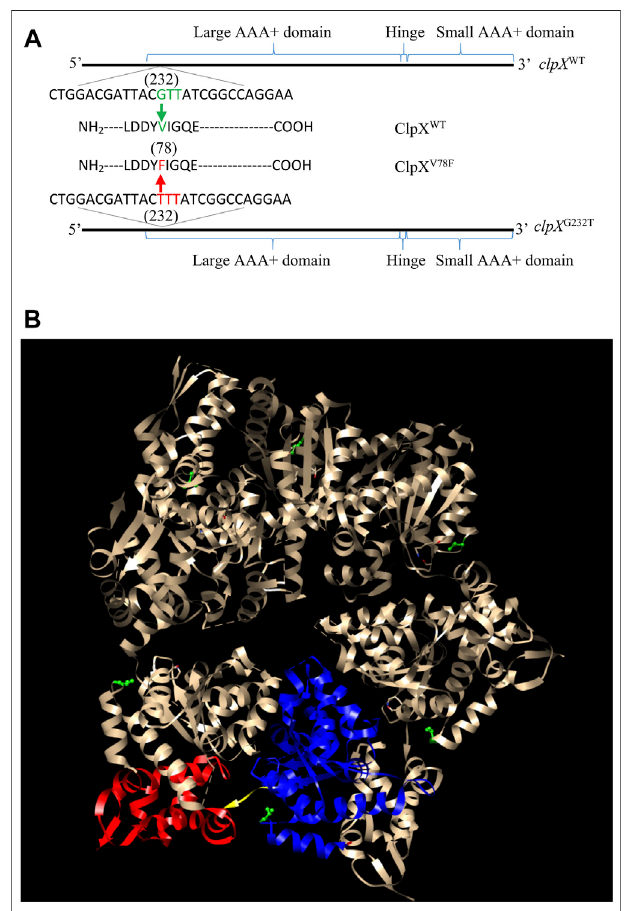
FIGURE 2 | Identi fi cation of the ClpX V78F mutation in the hypermotile isolates of CY706 and CY708. (A) The DNA and amino acid sequence of the clpX variantidenti fi ed.ThecorrespondingpositionsofthelargeAAA+domain, small AAA+ domain, and the hinge of the ClpX protein in its DNA sequence are marked. The G232T mutation in the clpX gene changed the codon of valine (GUU) into the codon of phenylalanine (UUU), resulting in ClpX V78F . (B) The structure of a ClpX hexamer (PDB code 3HTE) (Glynn et al., 2009). The 78th valine (V78) in Chain A-F has been highlighted in green (ball and stick). Chain B of the hexamer was used for showing the large AAA+ domain (blue ribbon), small AAA+ domain (red ribbon), and the hinge (yellow region). The highlighting of domains and residues was performed using the software Chimera 1.14 (Pettersen et al.,